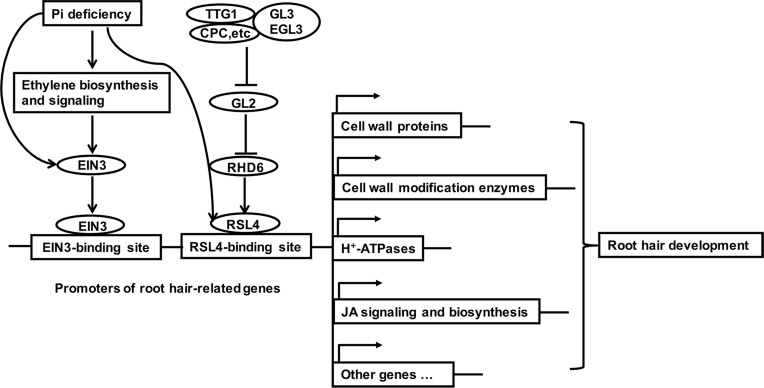
A model showing how ethylene enhances the expression of RLS4-targeted genes to promote root hair development.Above the promoter region, arrows indicate promotion, and perpendicular lines indicate inhibition.